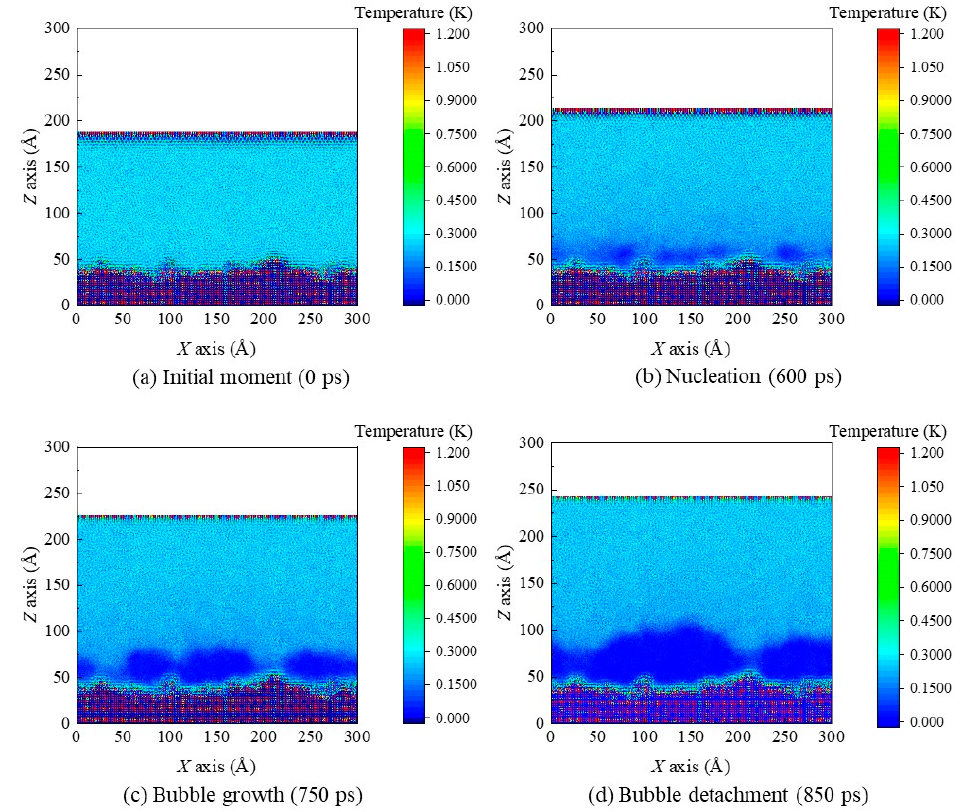
Figure 9. The temperature contours of the case α = 1.5 at ( a ) the initial moment, ( b ) the nucleation moment, ( c ) a certain bubble growth moment, and ( d ) the bubble detachment moment.